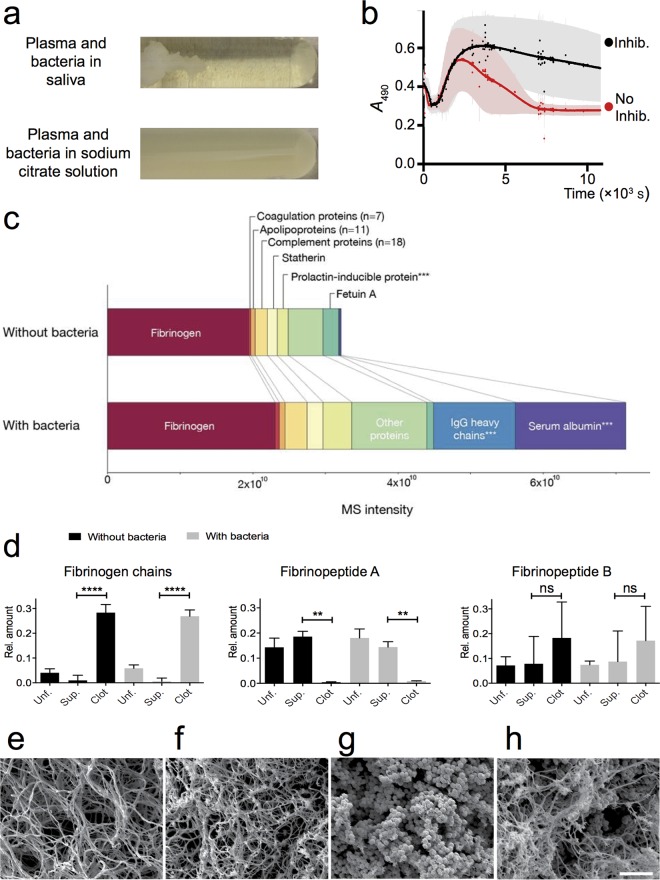
(a) Visualization of clotting and entrapment. Plasma and G45 bacteria were added to saliva or sodium citrate solution and incubated at 37°C. Chloramphenicol was used to prevent protein synthesis. (b) Clot dissolution. Plasma and G45 bacteria were added to saliva with (Inhib. [black]) or without (No Inhib. [red]) the protein synthesis inhibitor chloramphenicol. Clotting was monitored as the change in absorbance over time during incubation at 37°C. Measurements were performed every 6 s, and no curves have been fitted. Shown are the mean and 95% confidence interval (CI) for six replicates in two blocks, with different bacterial cultures for replicates and different donors of saliva and plasma for blocks. (c) Protein content of clots. Plasminogen-depleted plasma was incubated with saliva with or without G45 bacteria. The samples were then fractionated by centrifugation, and the pellets were washed. A total of 170 human proteins were identified and quantified by shotgun LC-MS/MS. The bar charts show the total human protein signal and the abundances of selected proteins and protein groups (for details, see Table S1 in the supplemental material) in the clots. Results are represented as median values from three replicates with different bacterial cultures and different donors of saliva. A group marked with *** contains proteins with significant differences (>2-fold change) (P < 0.001, multiple t test) between samples with and without bacteria: Ig gamma-1 chain C region, Ig gamma-2 chain C region, Ig lambda-1 chain C region, prolactin-inducible protein, and serum albumin. (d) Spatial separation of fibrinopeptides and fibrinogen chains. Plasminogen-depleted plasma was incubated with saliva with or without G45 bacteria. Some samples were fractionated by centrifugation. The pellet and supernatant (Sup.) as well as unfractionated (Unf.) samples were homogenized and trypsin digested. Fibrinopeptides A and B, as well as nine tryptic peptides located centrally within the fibrinogen α, β, and γ chains, were quantified by targeted proteomics (SRM MS). The acquired sample peptide intensities are plotted as fractions of the total peptide intensity within the sample group (with or without bacteria). Shown are the mean and standard deviation (SD) from three replicates with different bacterial cultures and different donors of saliva. The level of statistical significance is indicated by **** for P < 0.0001 and ** for P < 0.01, with “ns” indicating “not significant,” as assessed with the Welch corrected t tests. (e to h) Electron microscopy of clots with and without streptococci. (e) Saliva-plasma clot without bacteria. (f) Plasma clot without bacteria, formed by incubation of plasma with thrombin. (g) Saliva-plasma clot with bacteria. (h) Plasma clot with bacteria, formed by incubation with thrombin. The scale bar represents 5 μm.